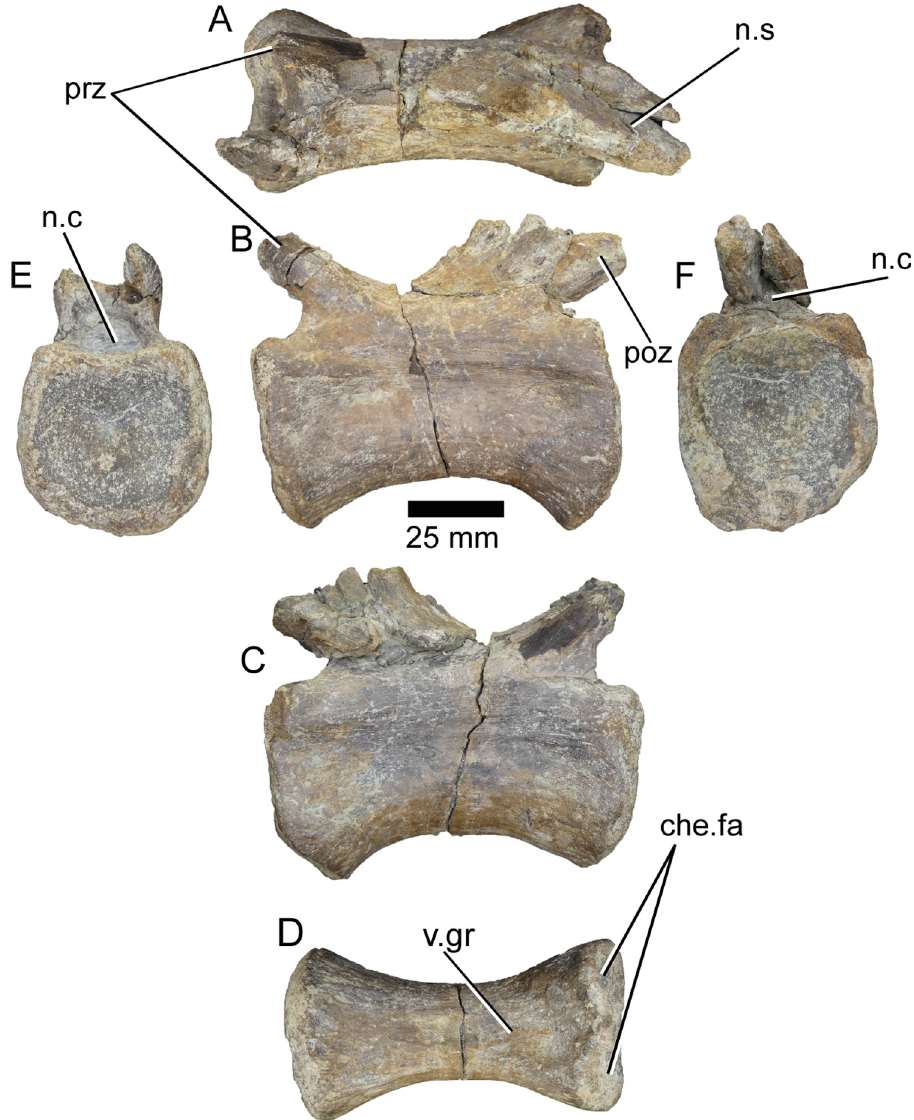
Fig 21. Caudal vertebra of Iberospinus natarioi (ML1190-241). A , dorsal, B, C; lateral, D , ventral, E , anterior, and F, posterior view. che.fa , chevron facets, n.c , neural canal, n.s , deformed base of the neural spine, poz , postzygapophysis, prz , prezygapophysis, v.gr , ventral